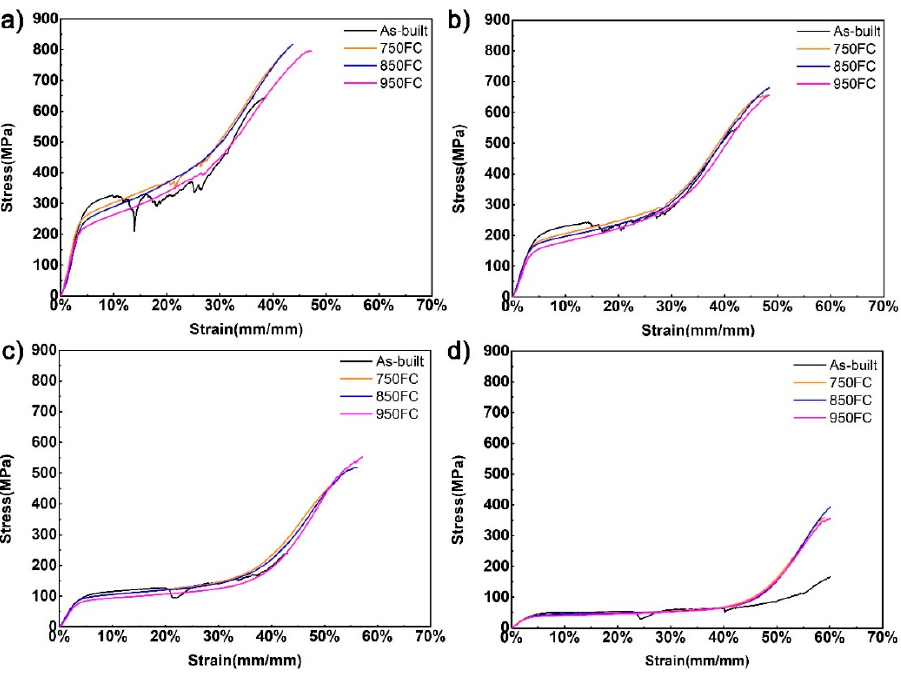
Figure 8. Compression stress–strain curves of porous Ti64 structures with different porosities after different heat treatments: ( a ) 46.3%; ( b ) 56.3%; ( c ) 66.2%; ( d ) 75.4%.